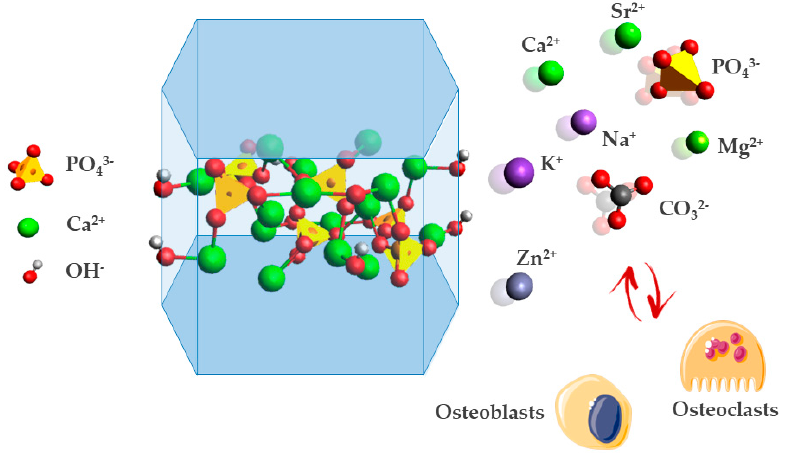
Figure 1. Pictorial illustration of the hydroxyapatite crystal structure and chemical signaling to bone